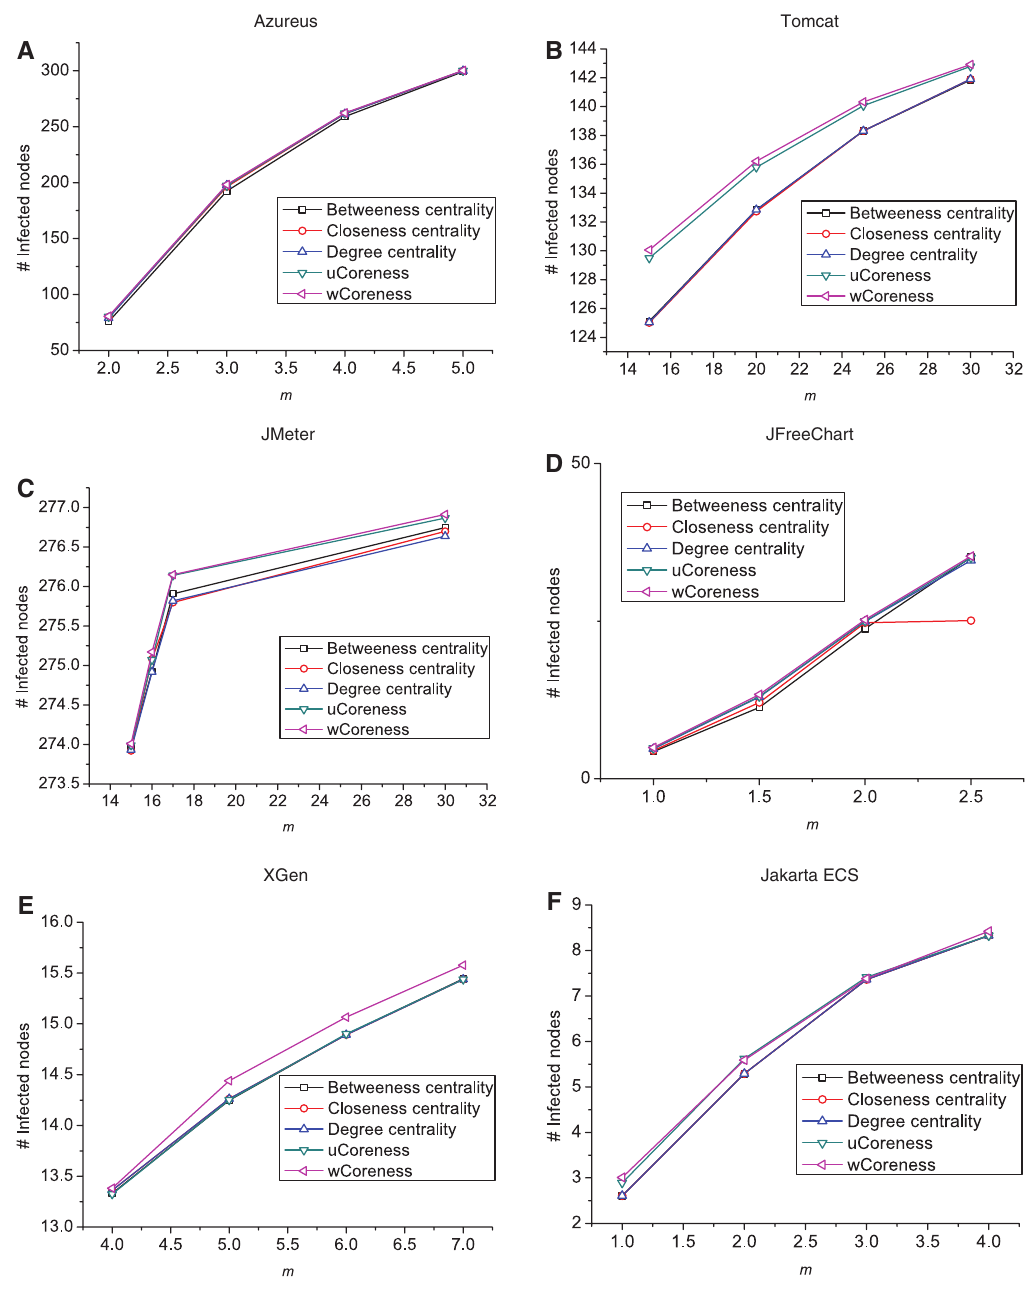
Figure 6. The Number of Infected Nodes Changes with the m